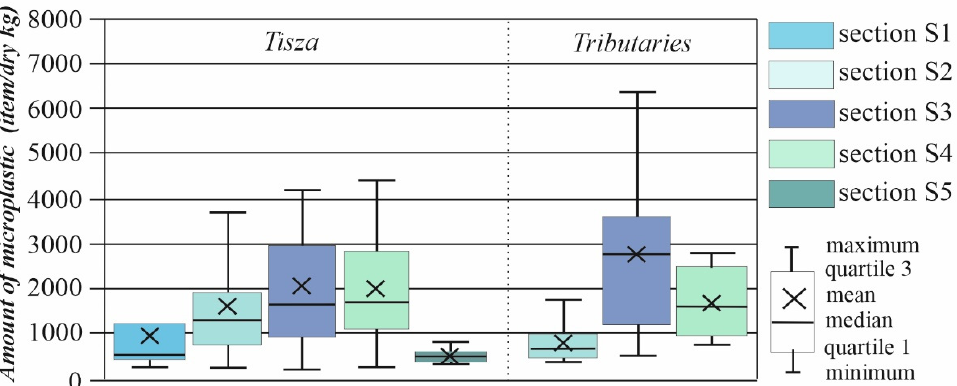
Figure 5. Differences in microplastic content (item/dry kg) of the sediments collected along the var- ious sections of the Tisza River (S1 ‒ S5) and its tributaries joining the given